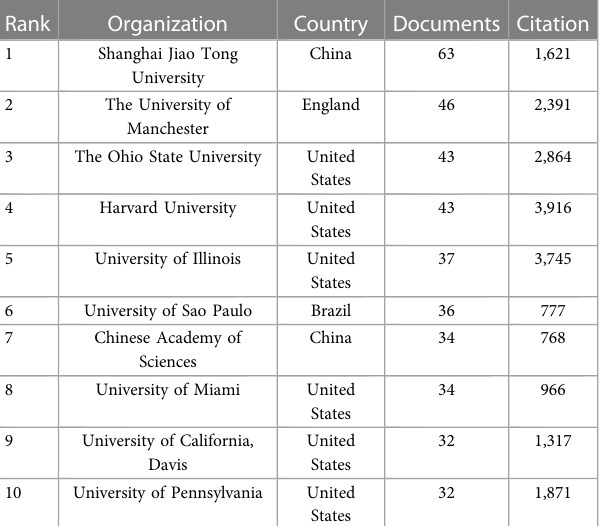
Figure 6 . The paper titled Mechanisms of disease-Cutaneous